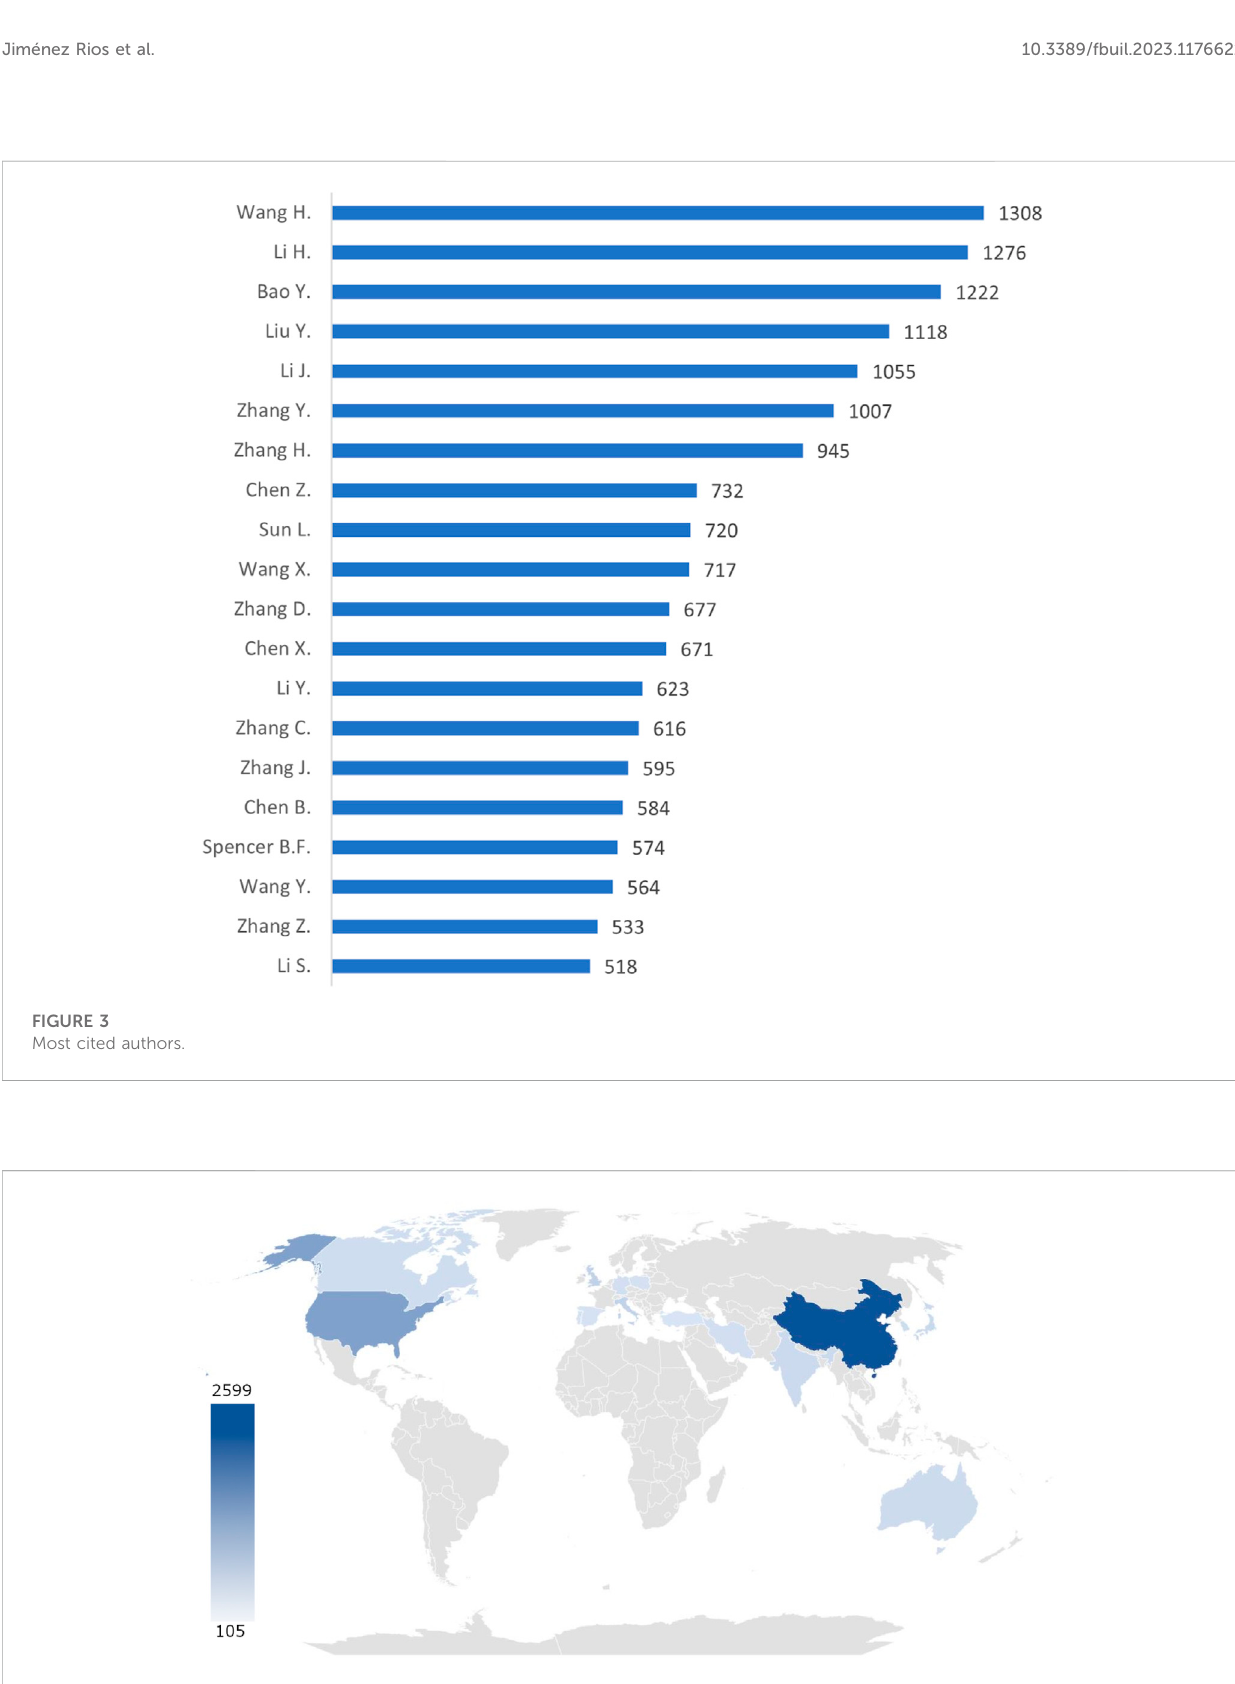
FIGURE 4 Documents per